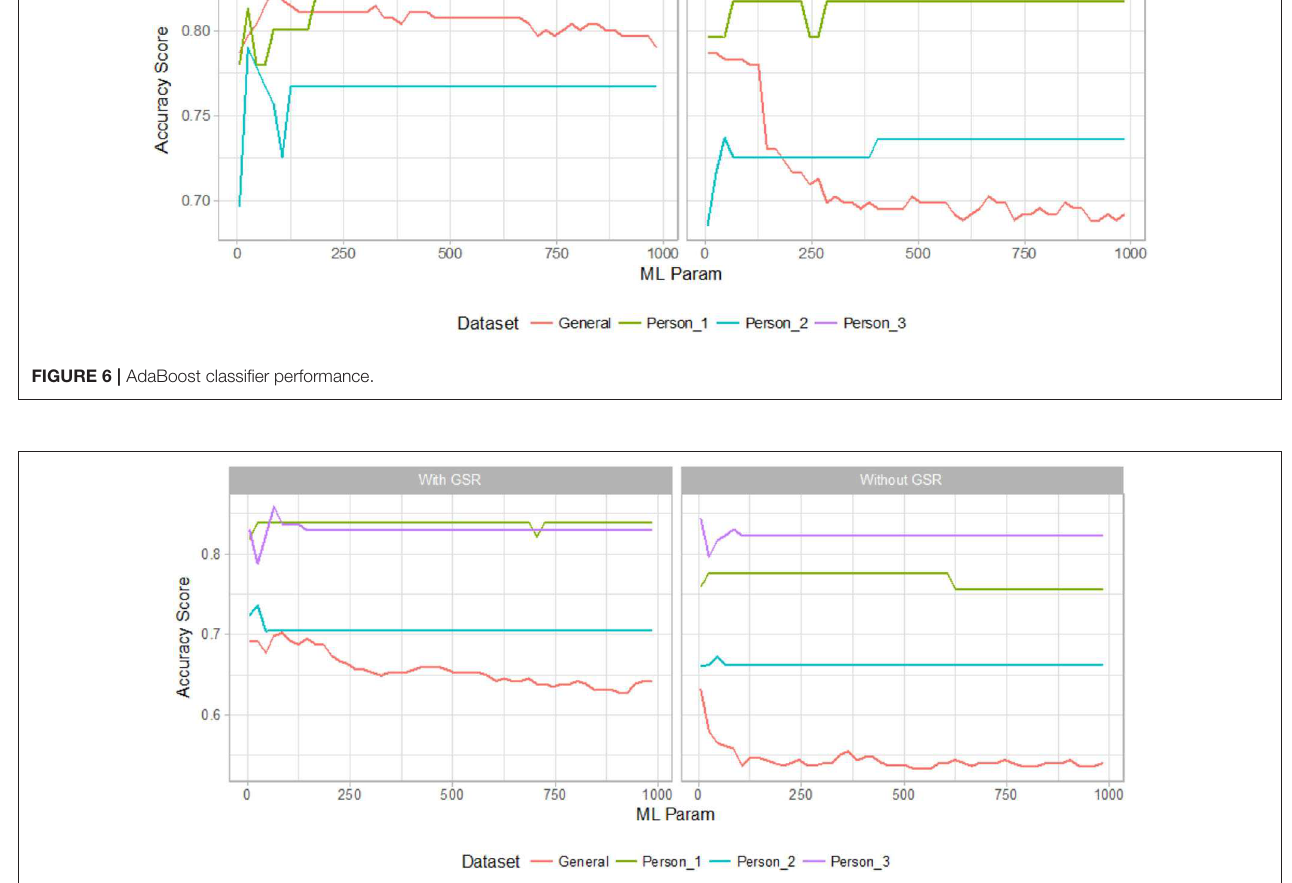
FIGURE 7 | Gradient boosting classifier